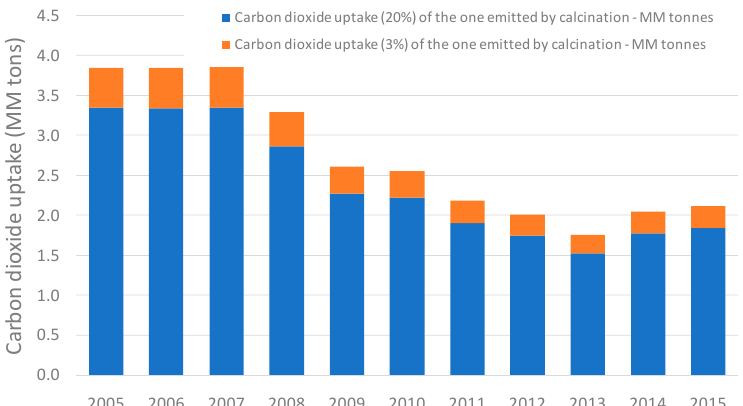
Figure 13. Carbon dioxide uptake by the cement-based materials produced with the Spanish cement manufactured between 2005 and 2015 considering the IVL simplified methodology [26].